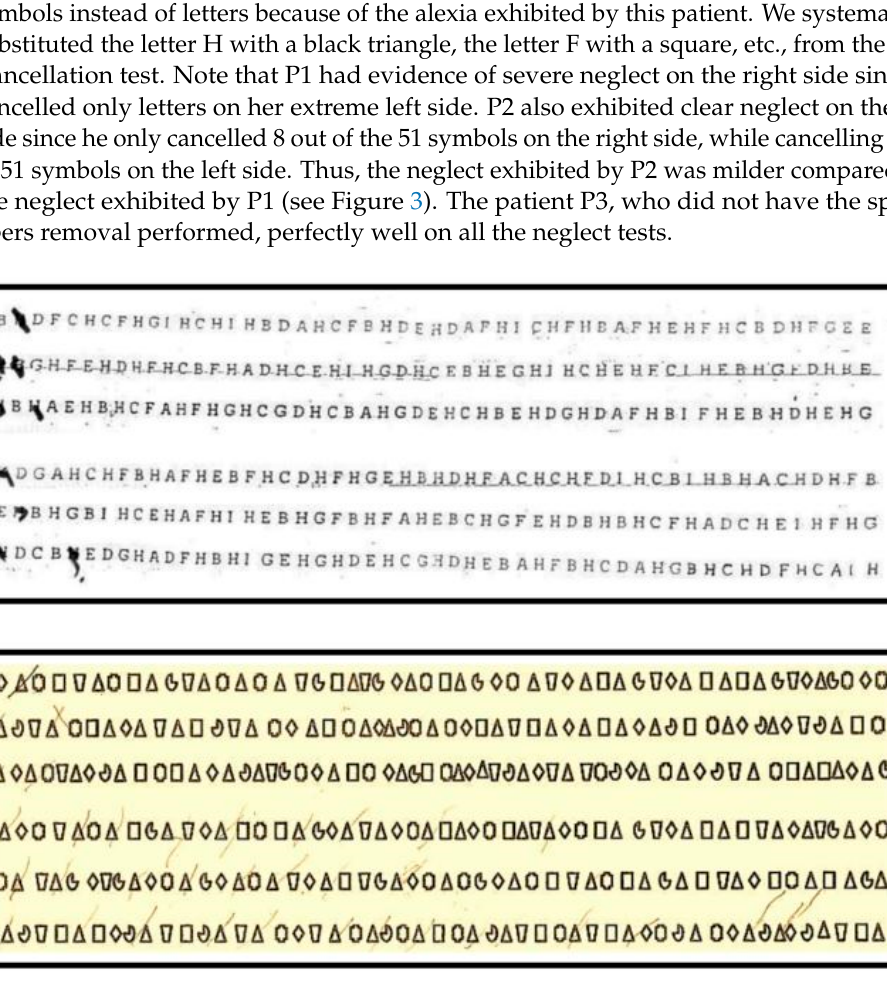
Figure 3. Cancellation Letter/Symbol tests. Upper panel shows the Letter Cancellation test performed by P1. She detected only 8 targets on her extreme left space. Lower panel shows the Symbol Cancellation test performed by P2. He detected 29 targets on his left space and 8 targets on his right space. Table 1. The clinical testing of P1 and P2 (post-surgery) revealed clear signs of right visuo-spatial neglect that was present in both the peripersonal and extrapersonal right half of space, but there were no signs of neglect in personal-body space. P3 performed correctly on all the neglect tests. Scores in bold indicate impaired performance. The sign “-” indicates a test that was not adminis- tered.